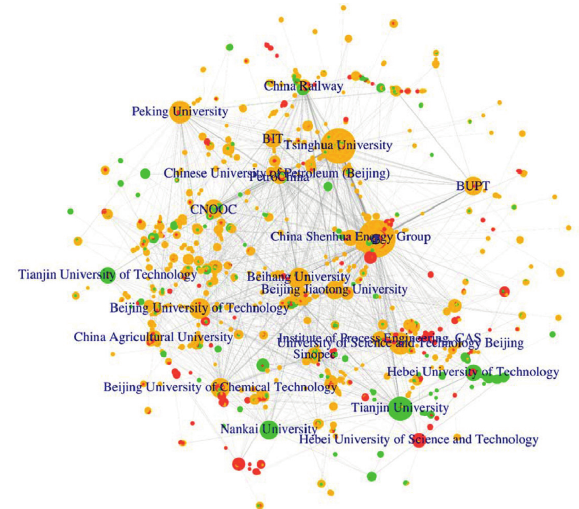
Figure 2: Visualization of the largest connect subgraph. Note: yellow nodes represent Beijing organizations, red nodes represent Hebei organizations, and green nodes represent Tianjin